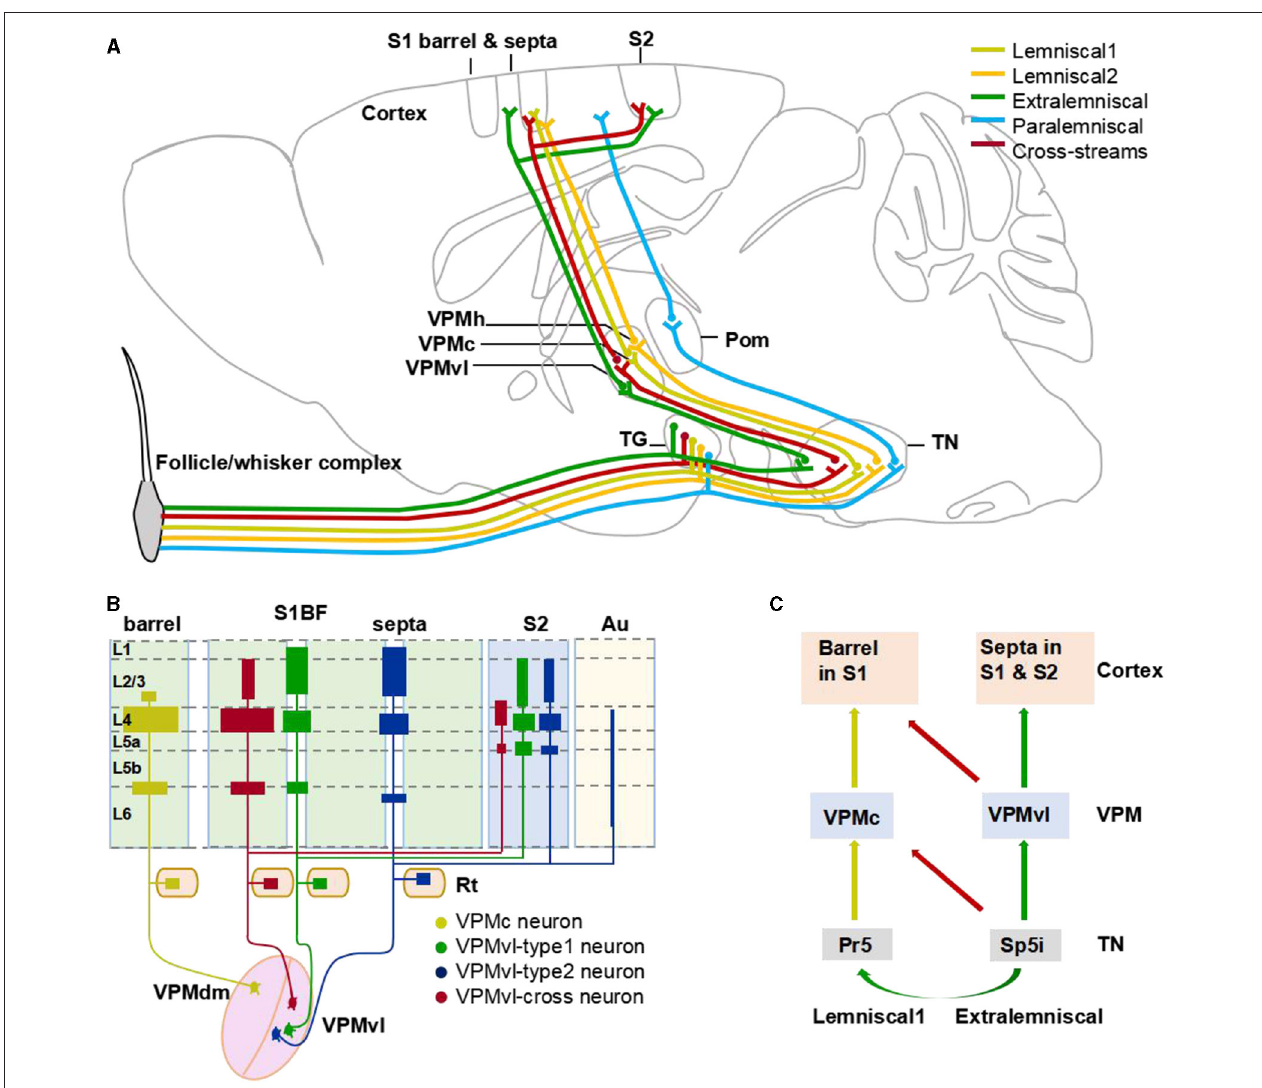
FIGURE 8 | The cross-streams enrich whisker system. (A) An updated circuitry model among the brainstem, VPM, and barrel cortex. The circuits revealed in this study are shown in red color, and the conventional circuits are shown in other colors. Brown lines represent the lemniscal1 pathway. (B) Schematic diagram illustrating the major thalamocortical axon distribution of organization of VPM neurons. (C) A model of cross-streams between lemniscal1 pathway and extralemniscal